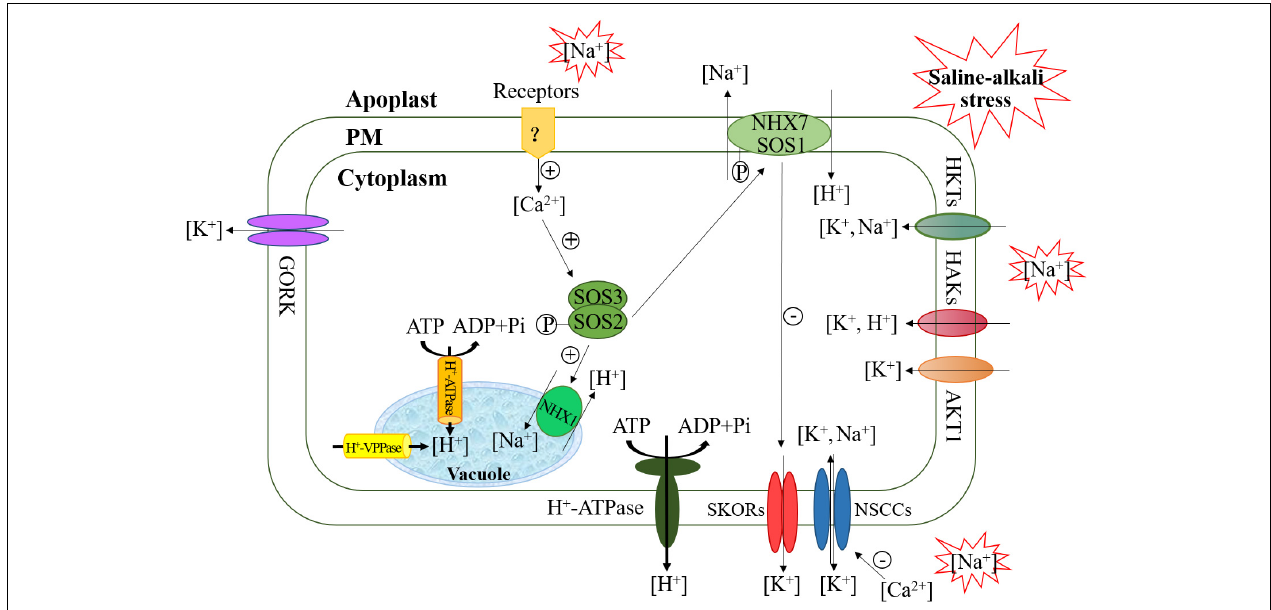
FIGURE 1 | Maintaining Na + -K + ion balance via channel proteins and